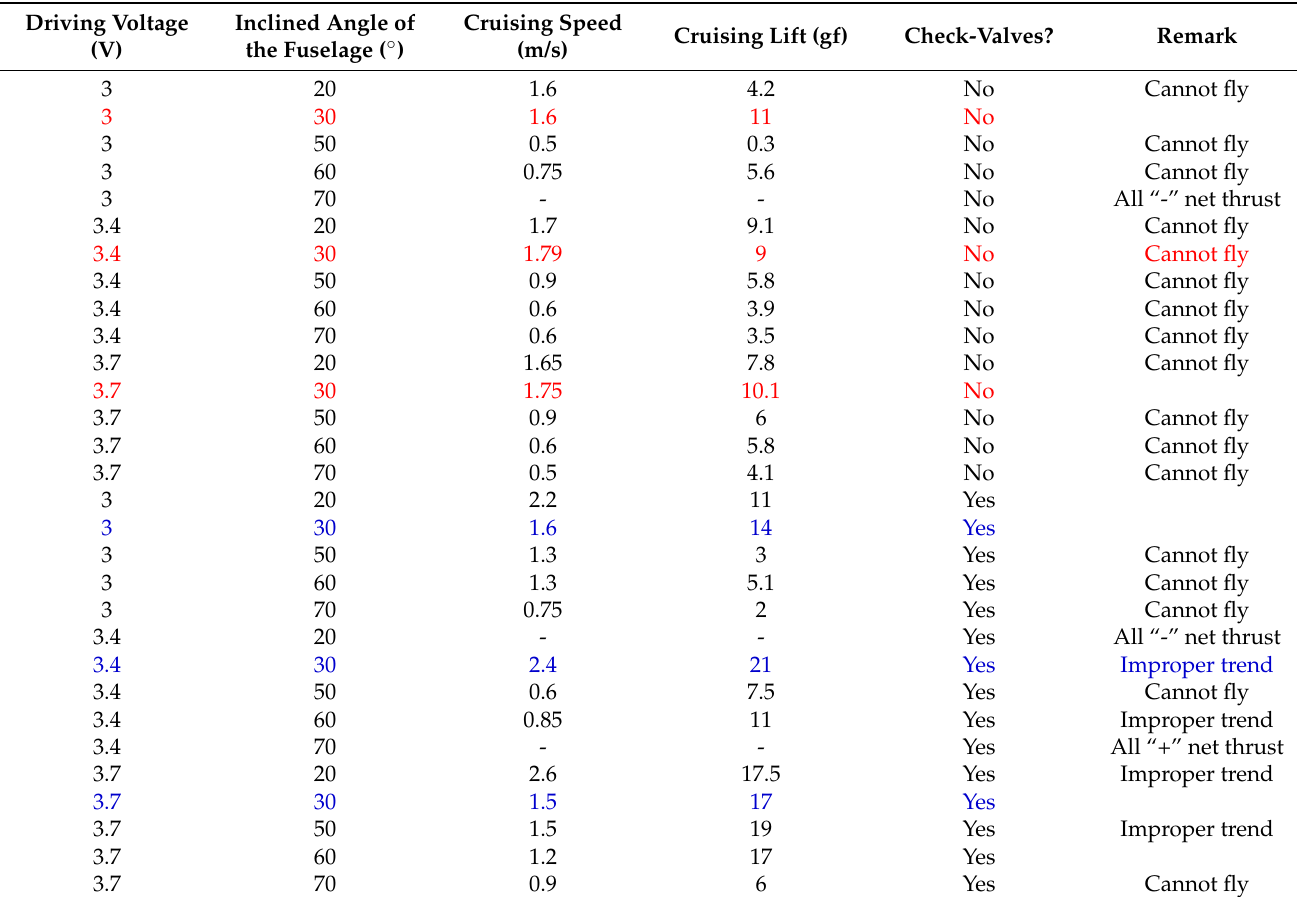
Table 3. The speed and lift during different cruising conditions (red and blue highlighted words are marked for comparison of without check-valve and with check-valve cases for acceptable lift